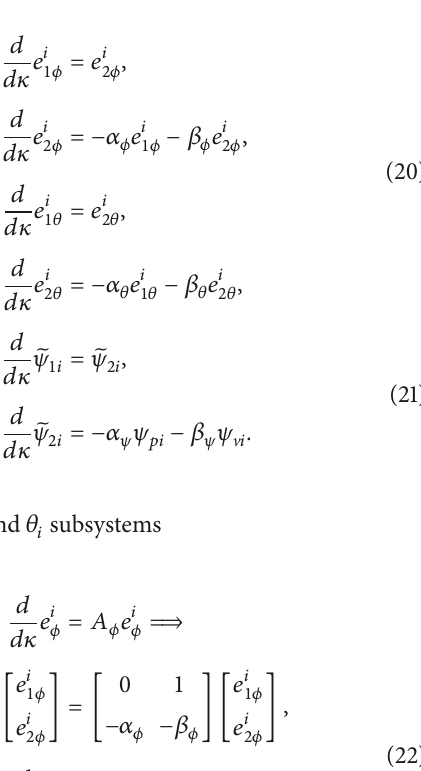
Figure 2: Block diagram of the event-based control